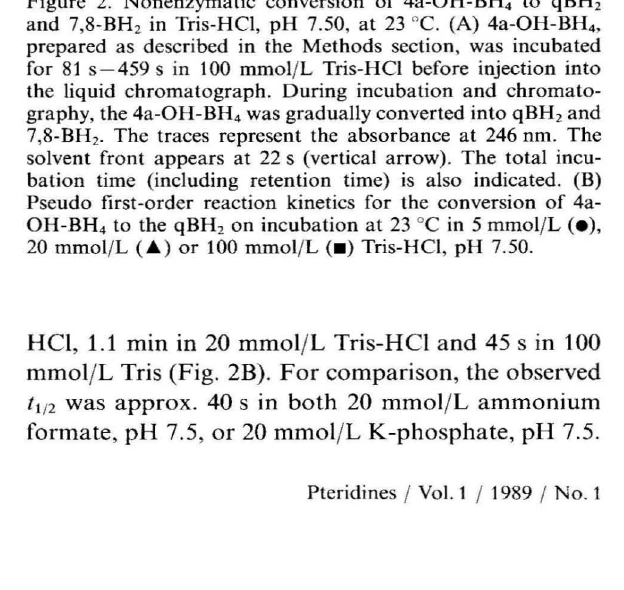
Figure 2. Nonenzymatic conversion of 4a-OH-BH. to qBHz and 7,8-BH2 in Tris-HCI, pH 7.50, at 23 "c. (A)